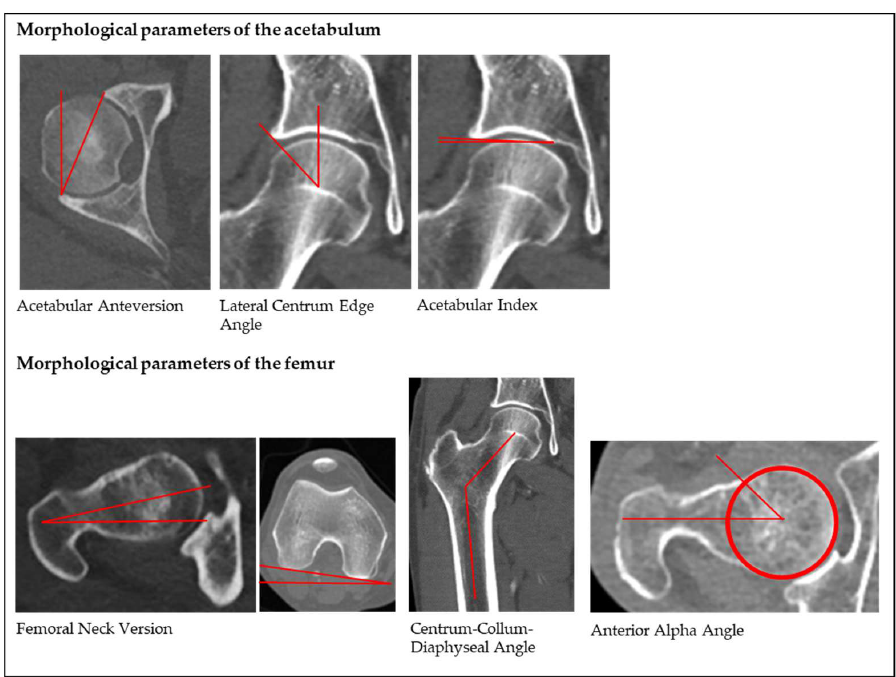
Figure 1. Schematic measurements of the analyzed morphological parameters.